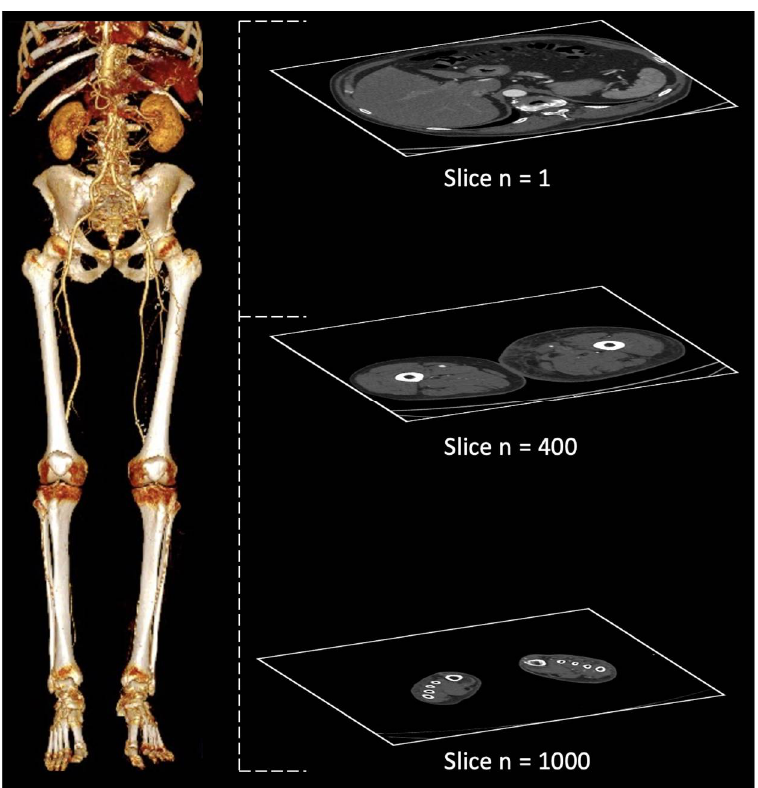
Figure 1. Example of a full 3D CTA scan of the lower limbs from slice 1 (proximal) to slice 1000 (distal): on the left, reconstructed volume-rendered images displaying the arterial tree; on the right, single slices at different levels.